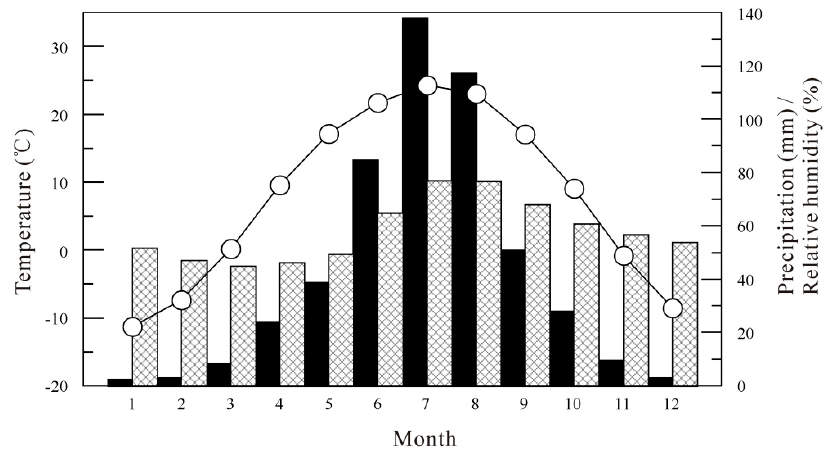
Figure 2. Distribution of monthly mean temperature (circles), precipitation (black bars) and relative humidity (crosshatched bars) from Fuxin meteorological station data during the period of 1950–2012.